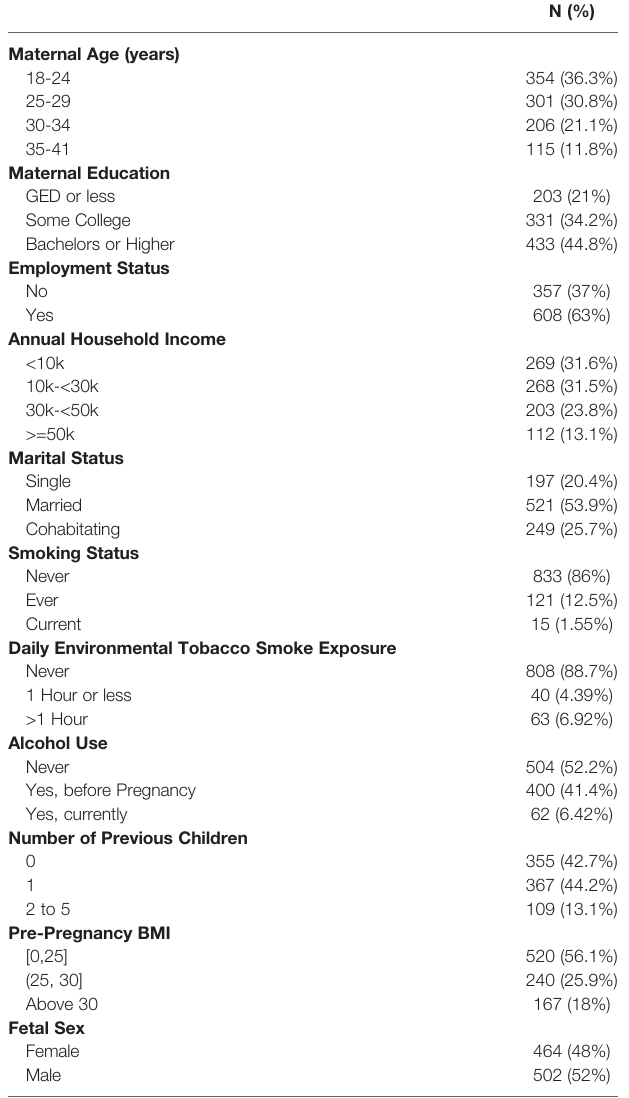
TABLE 1 | Maternal demographic characteristics of the study population (N=976).